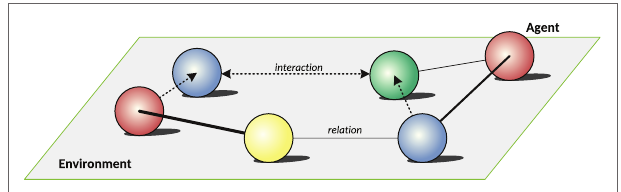
FigUre 3 | a schematic high-level Maser architecture